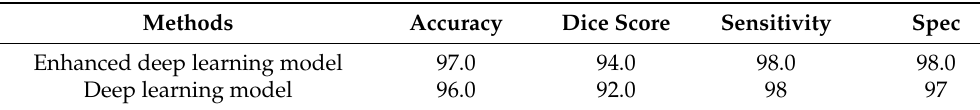
Table 1. Performance analysis (%) and comparison of the enhanced system with the method without an enhancement on the ISBI 2017 datatest.